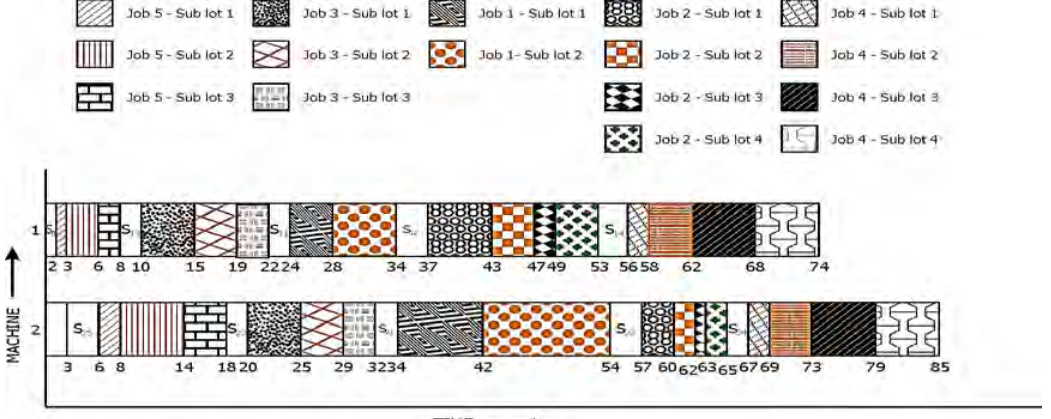
Fig.4 - Schedule for the Sequence 5-3-1-2-4